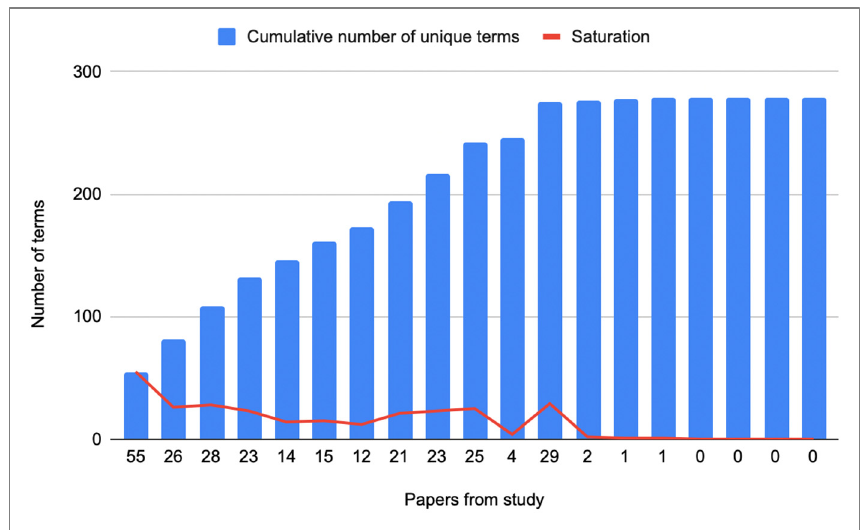
Figure 2. Saturation level as the number of novel terms added by a subsequent article. The papers were processed in the same order as in Table 2. The x-axis corresponds to the new terms provided by each paper after analyzing them in order.